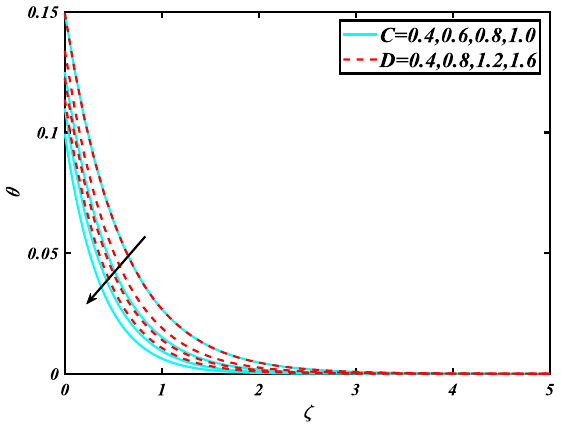
Figure 8. Significance of C & D for θ .